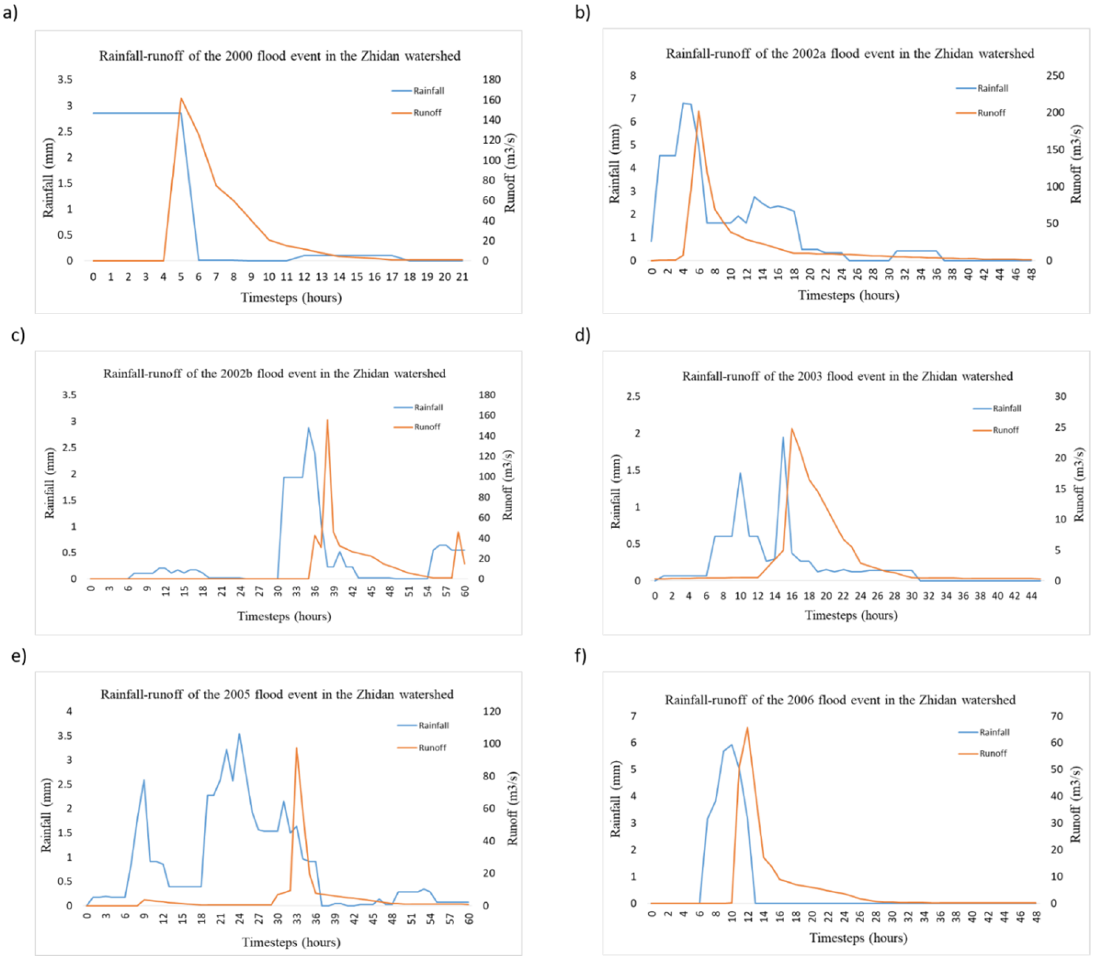
Figure 3. Rainfall–runoff relationships of the ( a ) 2000, ( b ) 2002a, ( c ) 2002b, ( d ) 2003, ( e ) 2005 and ( f ) 2006 flood events.